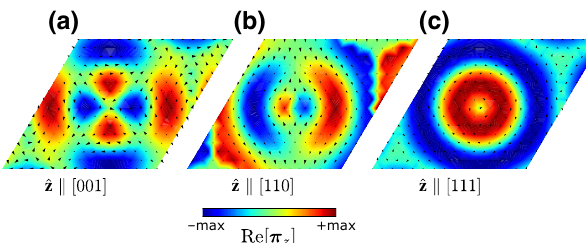
FIG. 8. Spatial profile of dynamical electric dipole moments in SkXs. (a)–(c) Real part of π i is plotted for the spin configuration of SkXs in Fig. 7(a) for (a) ˆ z (cid:9) [001], (b) ˆ z (cid:9) [110], and (c) ˆ z (cid:9) [111], which are defined in Eqs. (D4)–(D6).